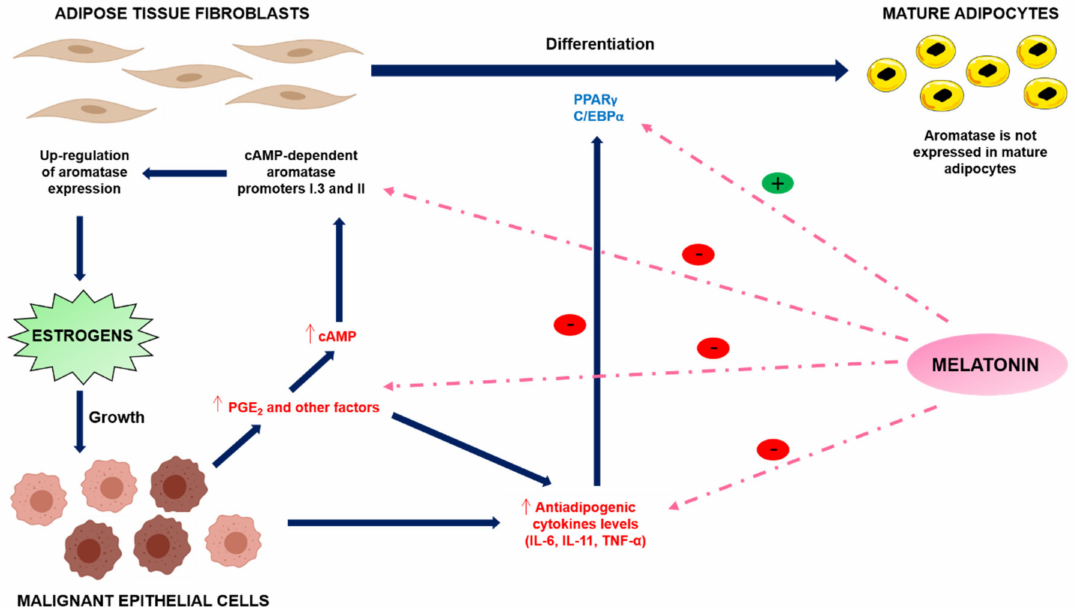
Figure 4. Interactions between adipose and malignant epithelial tissues: the desmoplastic reaction. Melatonin interferes with the desmoplastic reaction by stimulating the differentiation of preadipocytes into adipocytes and decreasing the aromatase activity of fibroblasts through the inhibition of the antiadipogenic cytokines expression of TNF- α , IL-6, and